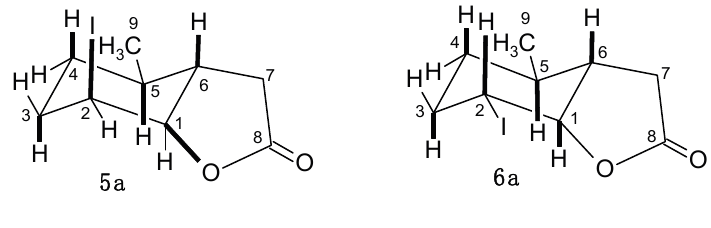
Figure 2. Structures of iodolactones 5a and 6a .